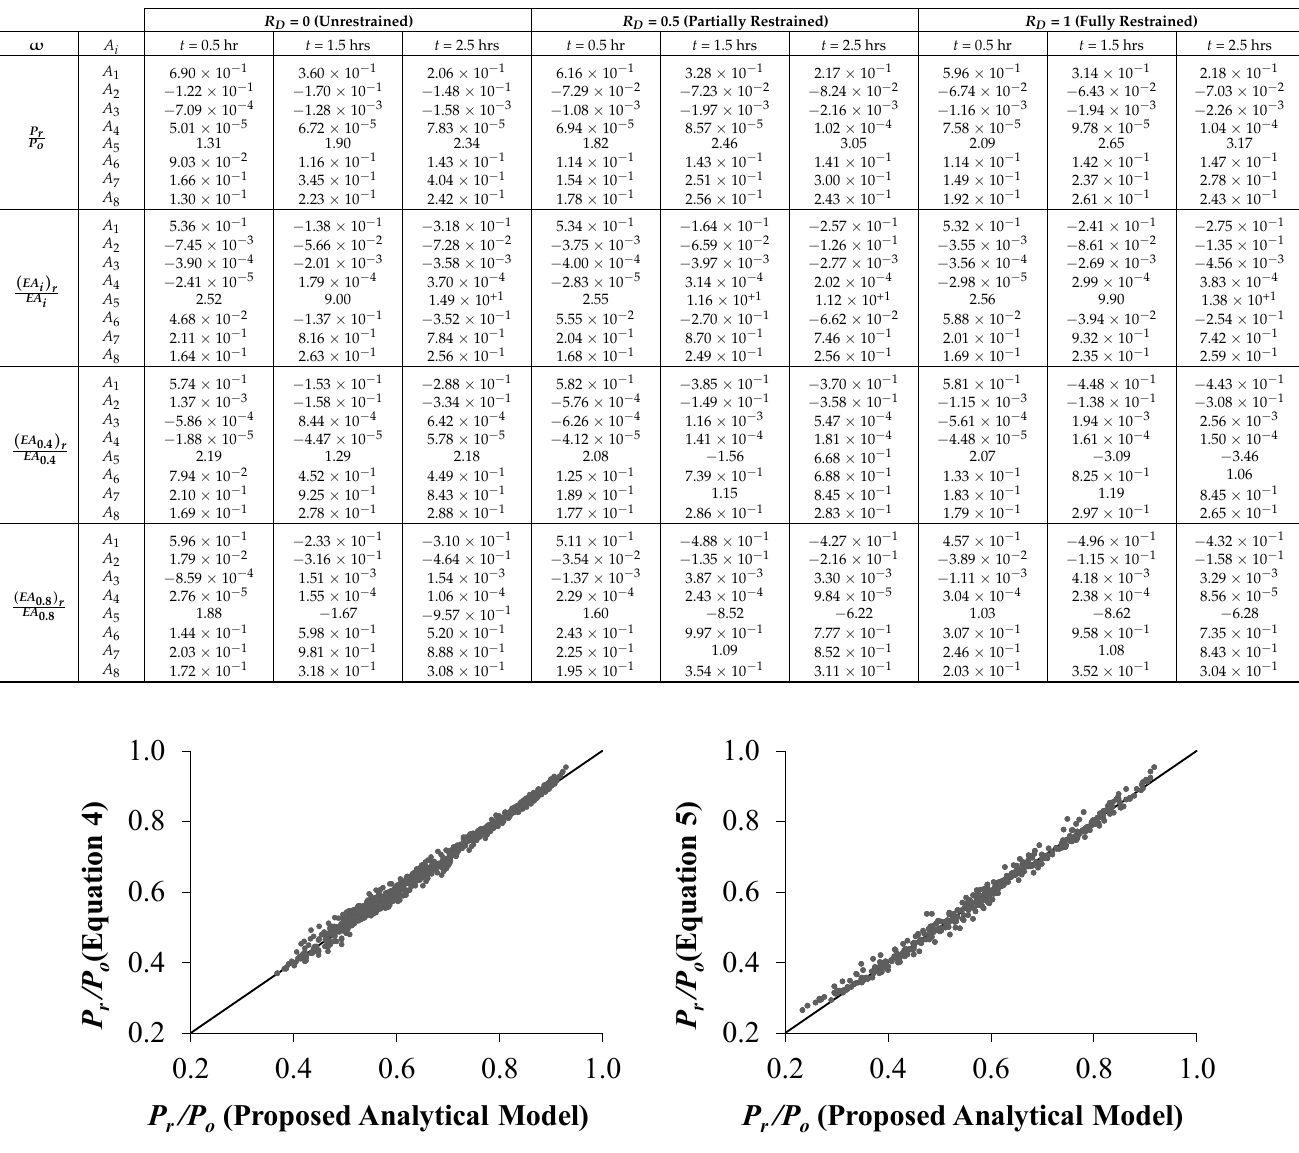
Table 2. Coefficient of Equation (4) for rectangular sections.